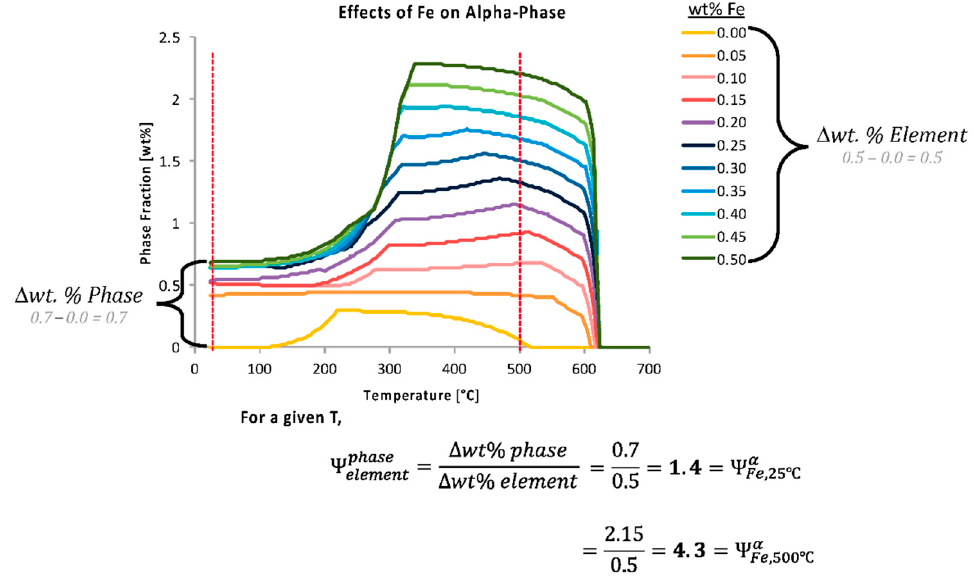
Figure 9. Variation of the prediction of the equilibrium alpha phase in Al 6061 with a content variation of iron according to the legend provided. Two vertically dashed lines were superimposed upon the phase fraction versus temperature curves at 25 and 500 °C, respectively, to identify the temperatures associated with the embedded demonstration of two 𝜓 s.